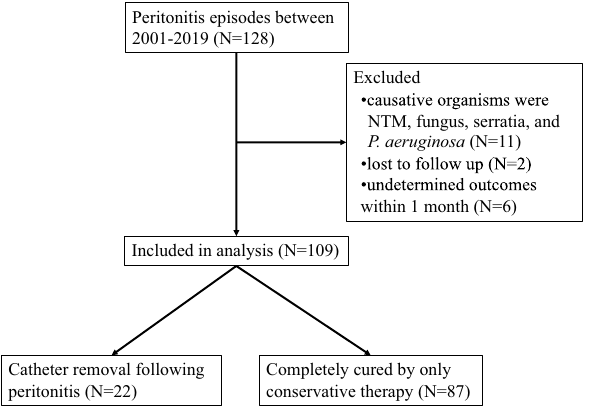
Figure 1. Chart showing flow of the study.